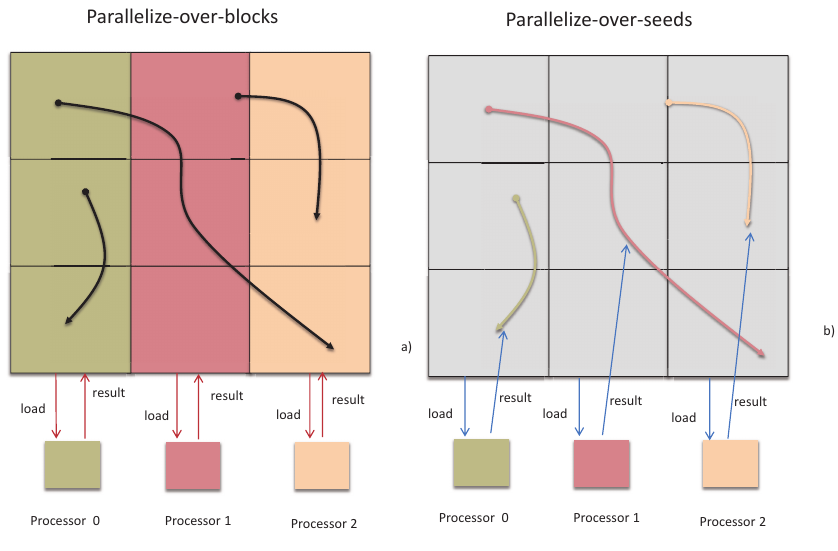
Figure 1. Two typical parallel vector field data processing paradigms. ( a ) In parallelize-over-blocks, each server preloads and calculates part of the data. ( b ) In parallelize-over-seeds, each server preloads all the data, but calculates only part of